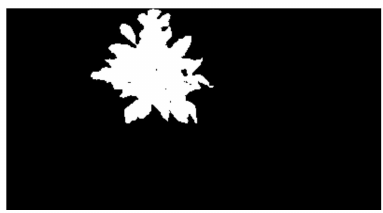
Figure 4. The reference segmentation image.